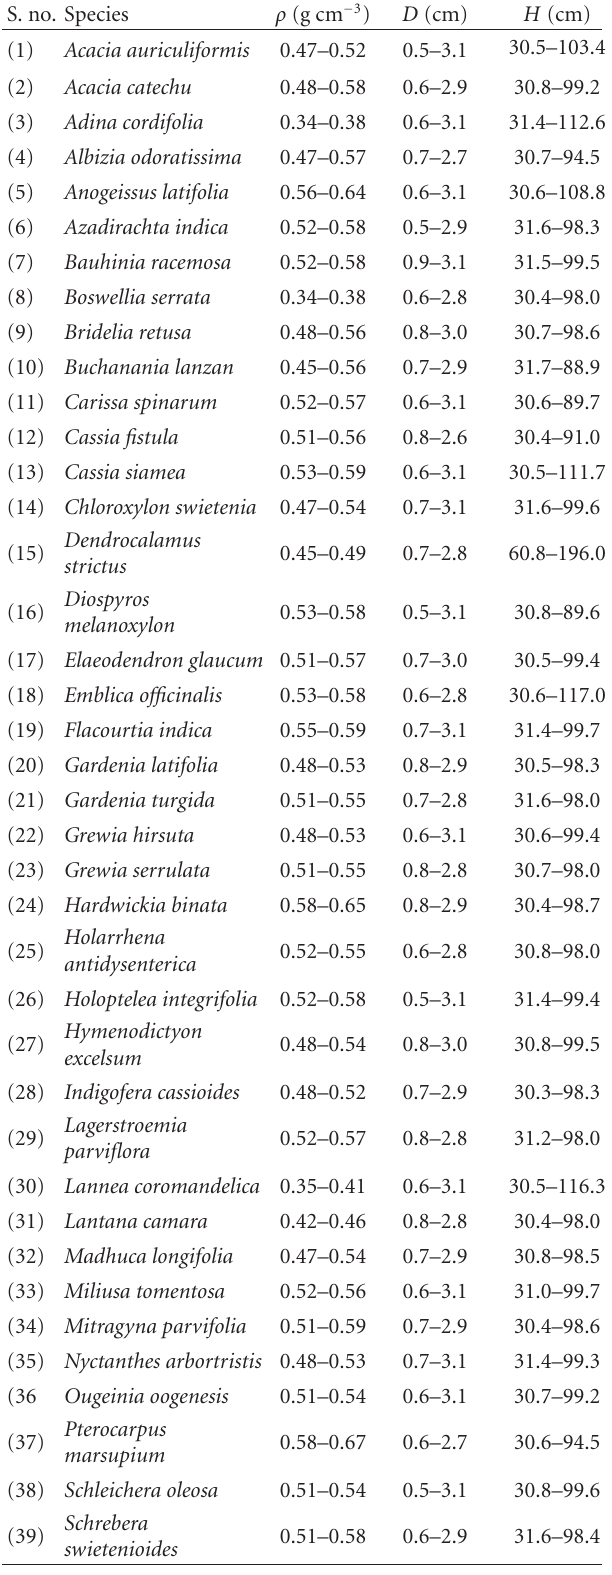
Table 1: Range of stem diameter ( D ), height ( H ), and wood- specific gravity ( ρ ) of the juvenile tree species harvested from the study site. n = 10 per species.